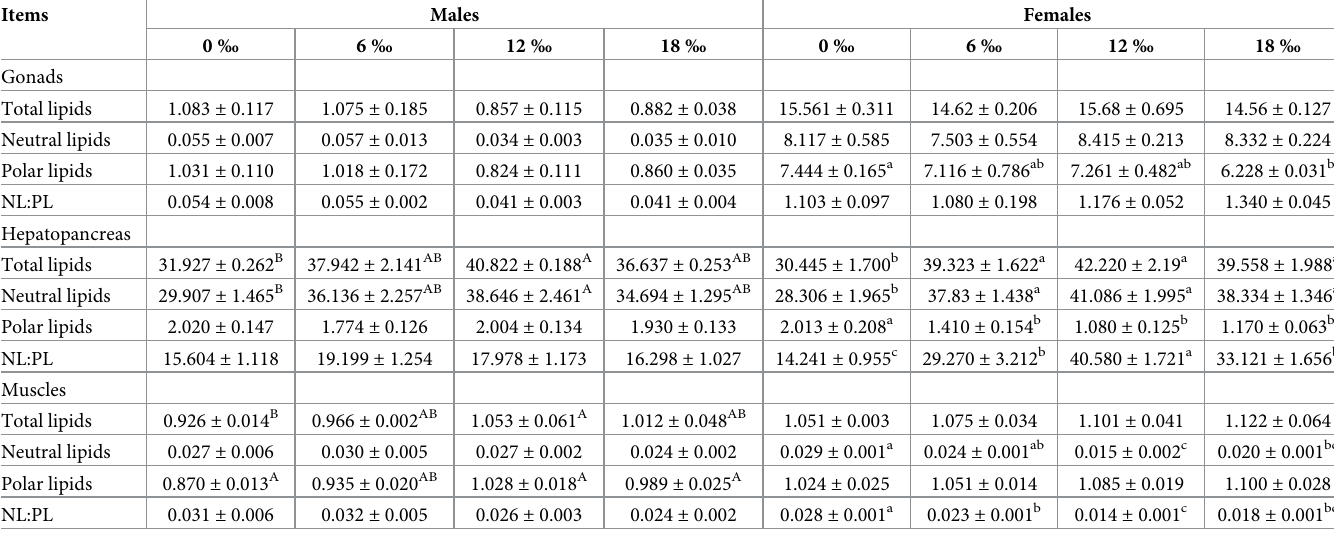
Table 1. The contents of total lipids, neutral lipids and polar lipids (% wet tissue) and ratio of neutral lipids and polar lipids in the tissues of adult E . sinensis . Items Males Females 0 ‰ 6 ‰ 12 ‰ 0 ‰ 12 ‰ 18 ‰ Gonads Total lipids